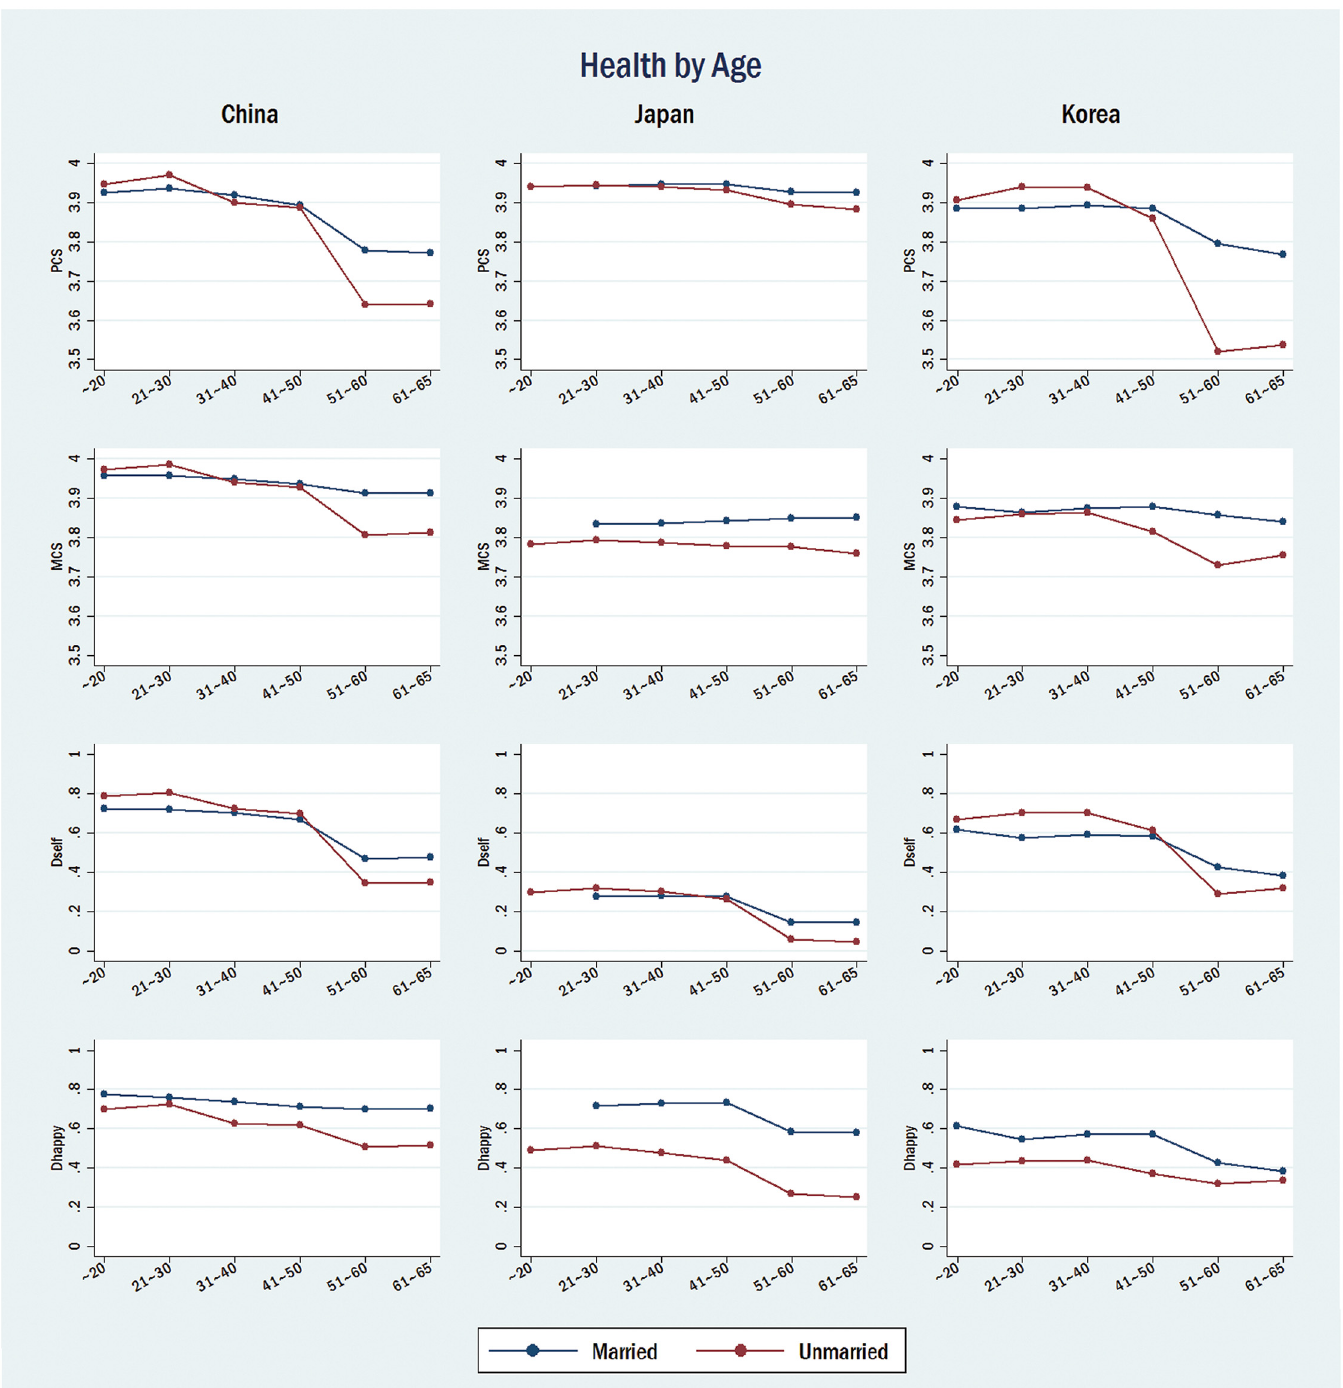
Fig 3. Predicted Marriage Protection Effects with Age. Rows correspond to health indicators, columns to countries. Blue line denotes health of married respondents, and red line denotes health for unmarried respondents.